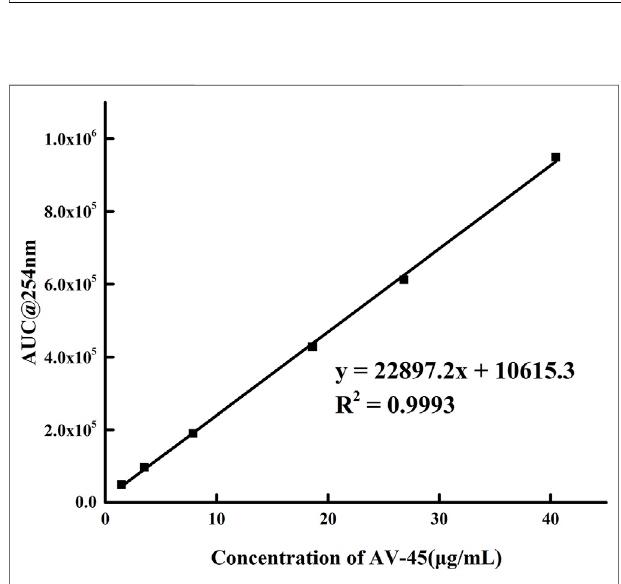
FIGURE 3 | Retention times of AV-45 in analytical HPLC column with different mobile phase ratios. The arrow points to the AV-45 standard peak.